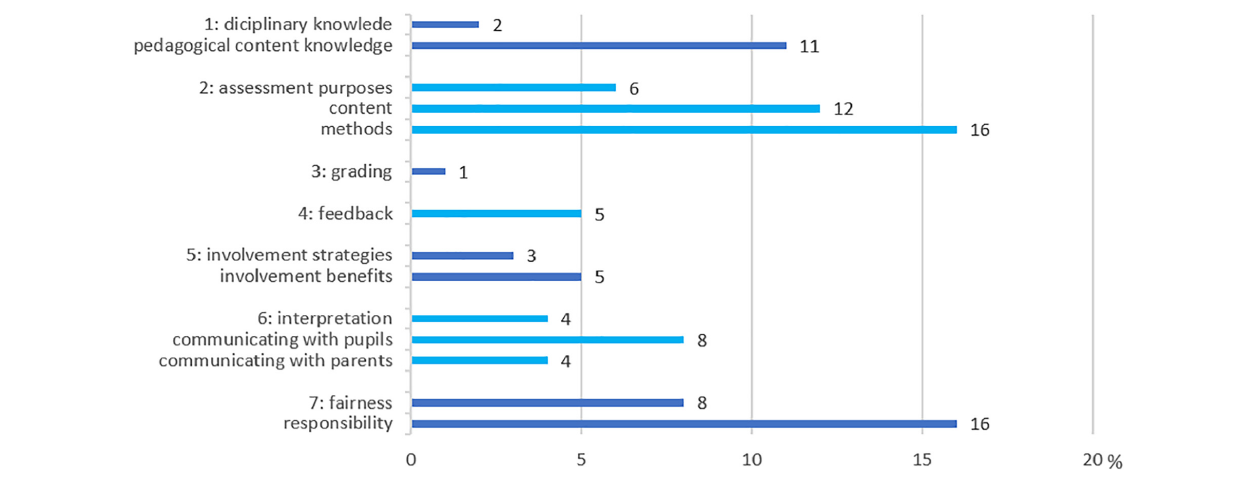
Frontiers in Education |